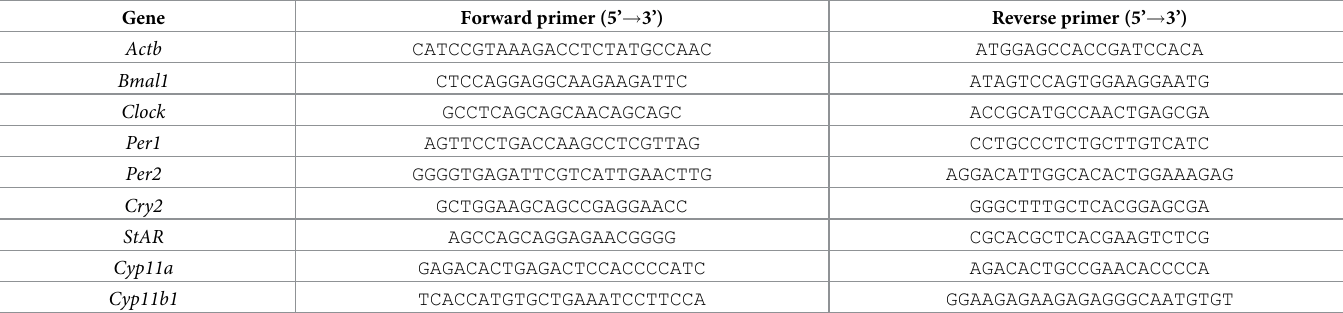
Table 1. Primer sequences for RT-PCR